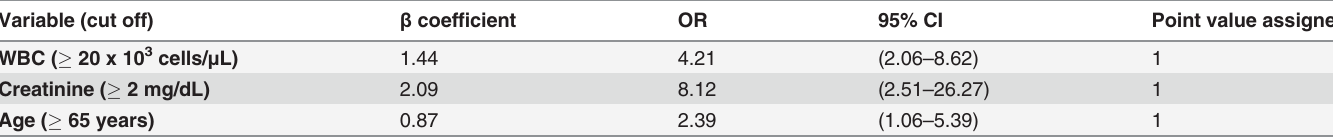
Table 2. Predictors of severe C . difficle infection in the Boston cohort (n = 263). Variable (cut